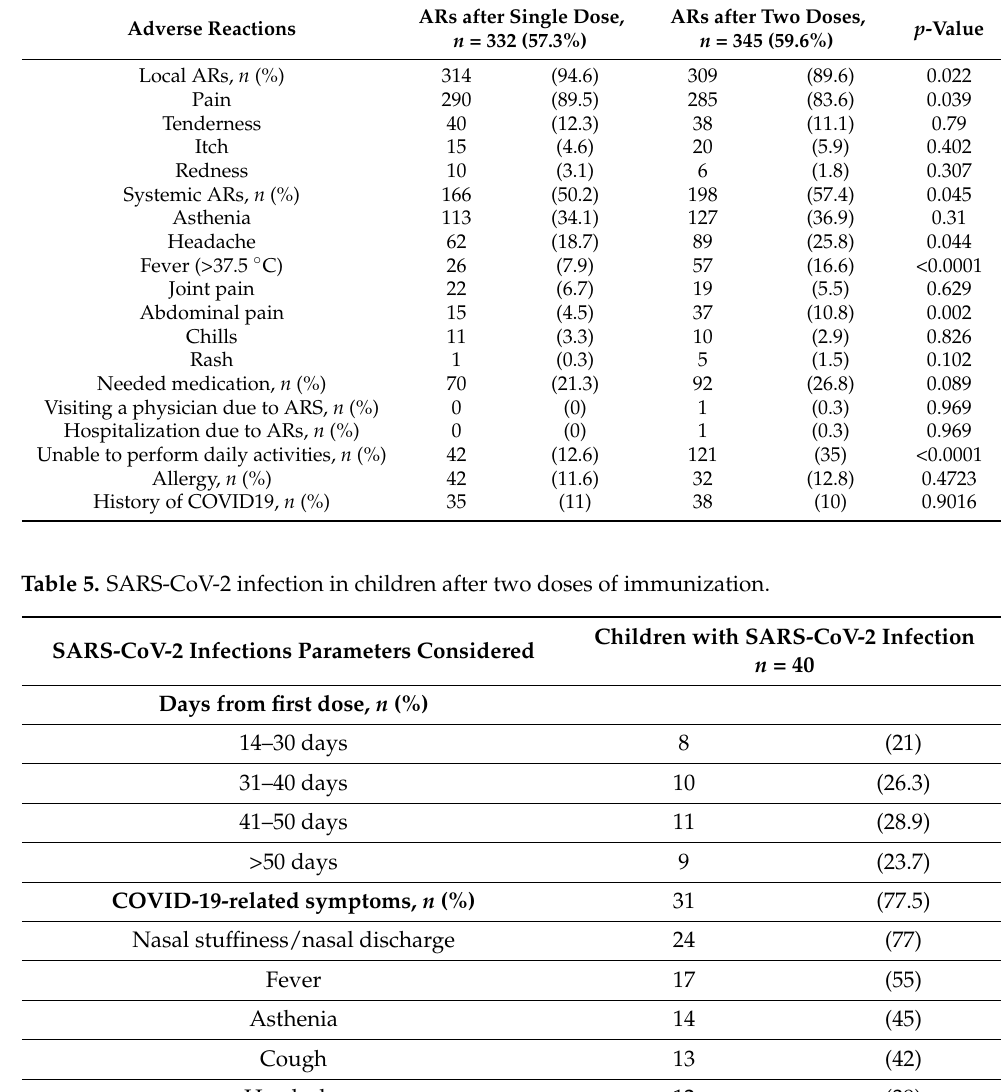
Table 4. Absolute numbers and relative frequencies of adverse reactions after the first and the second dose of BNT162b2. Characteristics of patients are also included.